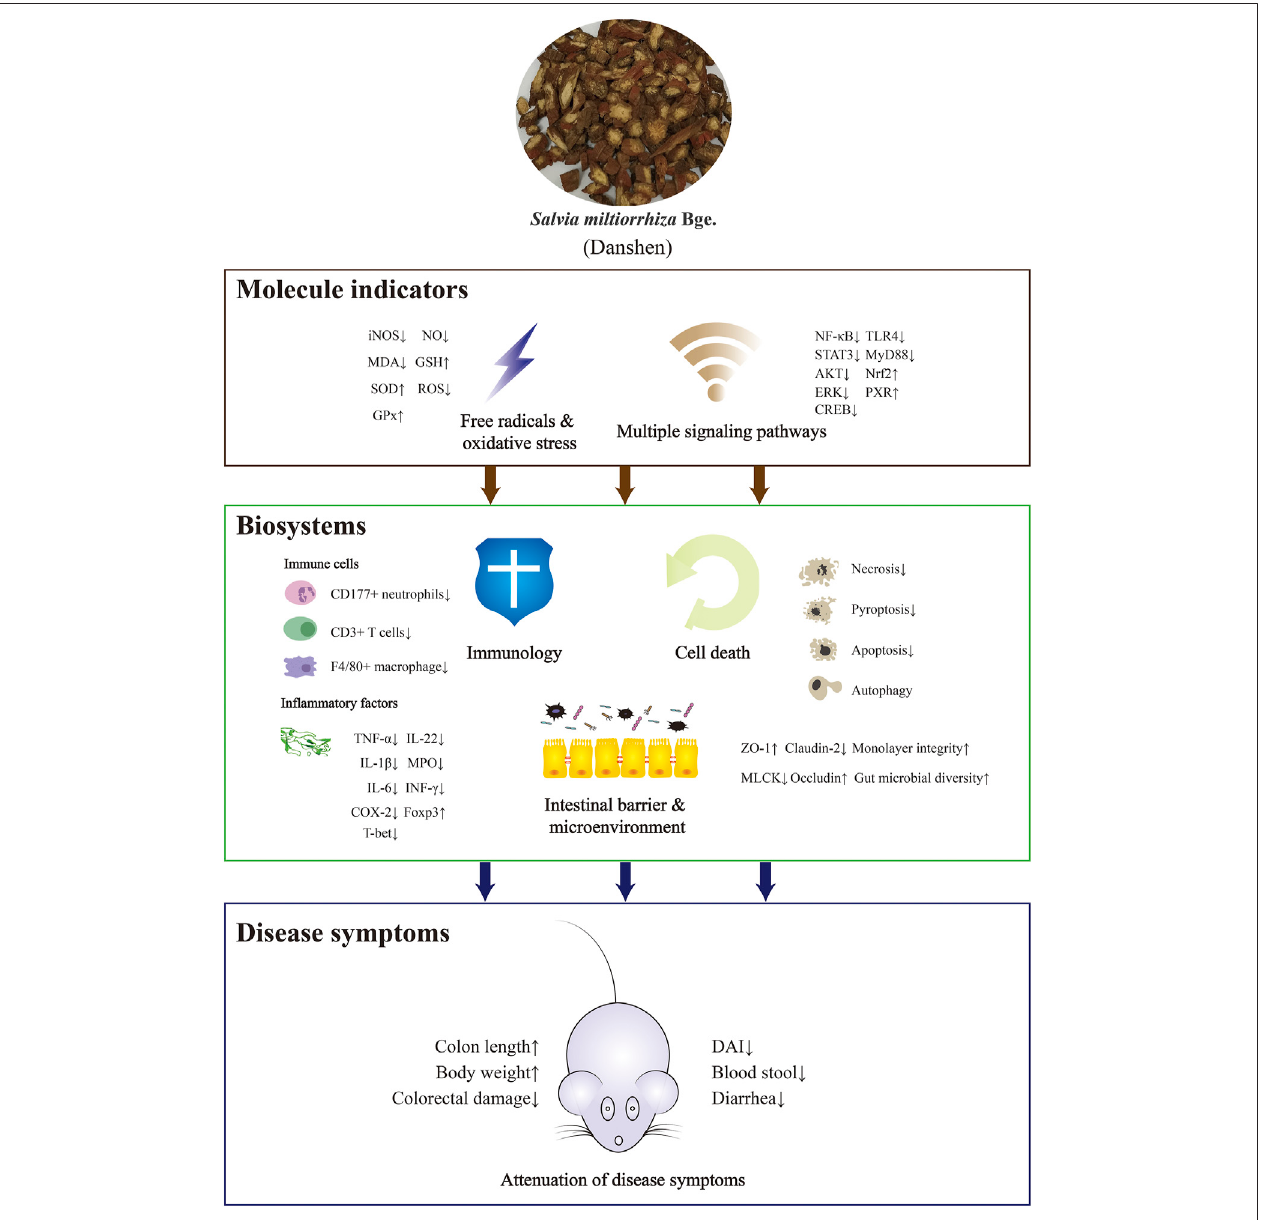
FIGURE 2 | The mechanisms of action of Danshen as a treatment of in fl ammatory bowel disease (IBD). Danshen exhibited ameliorative effects on IBD among molecular indicators, biosystems and symptoms. The up or down arrows indicated promoting or inhibitory effects of Danshen on the disease indicators.